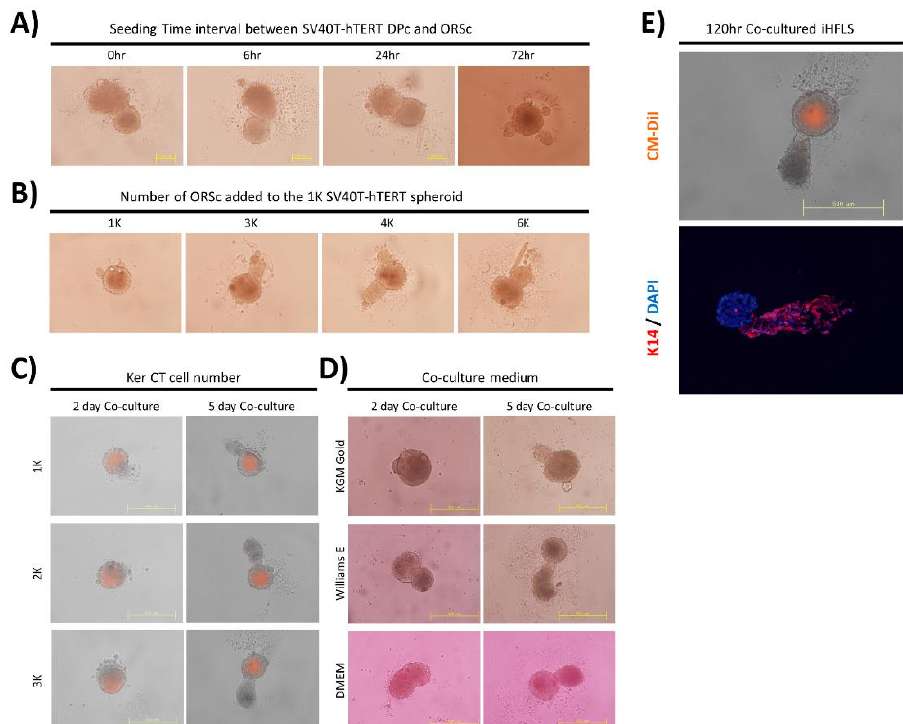
Figure 3. Optimal conditions for HFLS formation. ( A ) The time interval between the SV40T-hTERT DPc seeding for the spheroid formation and the start of co-culture with ORSc; approximately 1000 cells of SV40T-hTERT DPc and 3000 cells of ORSc were used. ( B ) Regulating co-cultured ORSc: Elongation of the keratinocyte layer in HFLS is prominent in the range of 3000–4000 ORSc. ( C ) Regulating immortalized keratinocyte (Ker-CT) cell numbers in HFLS composed of immortalized cells only: Addition of more keratinocytes results in larger iHFLS. ( D ) Variation of iHFLS formation according to culture medium regulation: iHFLS cultured in William’s E medium exhibits a more linear form than in other media conditions. ( E ) The cell arrangement in iHFLS using fluorescence observation: Cellular arrangement similar to hair follicles was observed using a cell tracker attached on SV40T-hTERT DPc and immunostaining of keratin 14 (K14) keratinocyte biomarker.